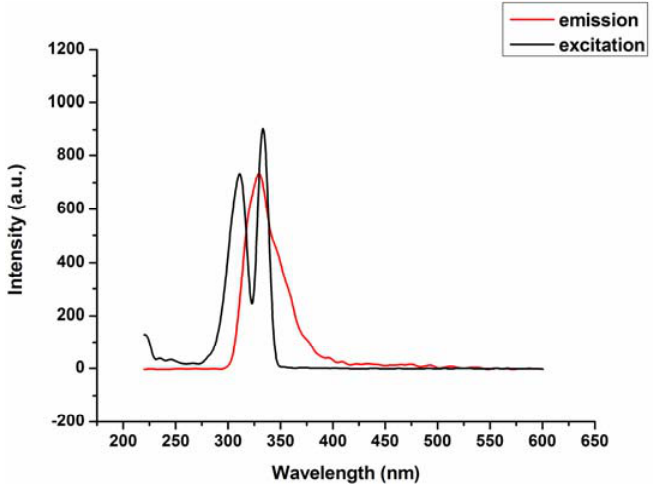
Figure 8. Fluorescence emission spectra of complex 1 in the solution of methanol ( λ = 312, λ = 328). ex em